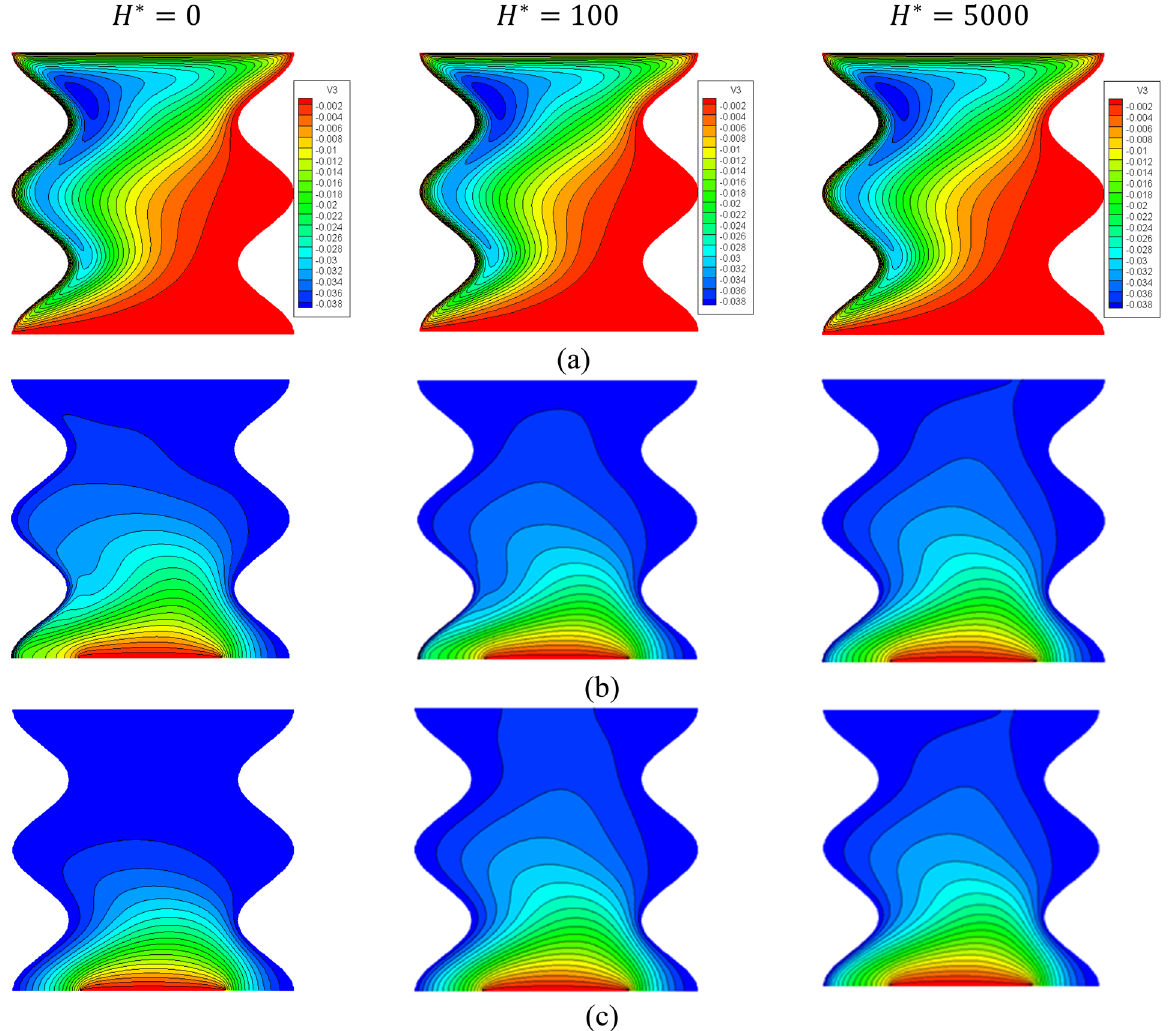
Figure 14. Contours of ( a ) streamlines, ( b ) isotherms of a fluid phase, and ( c ) isotherms of a solid phase below the changes on the inter-phase heat transfer coefficient H ∗ for a hybrid nanofluid at φ Cu = φ TiO 2 = φ/ 2, φ = 0.05, B = 0.5, Q = 1, R d = 0.5, Da = 10 k fs = 1, D = 0.5, k r = 1, Ha = 10.